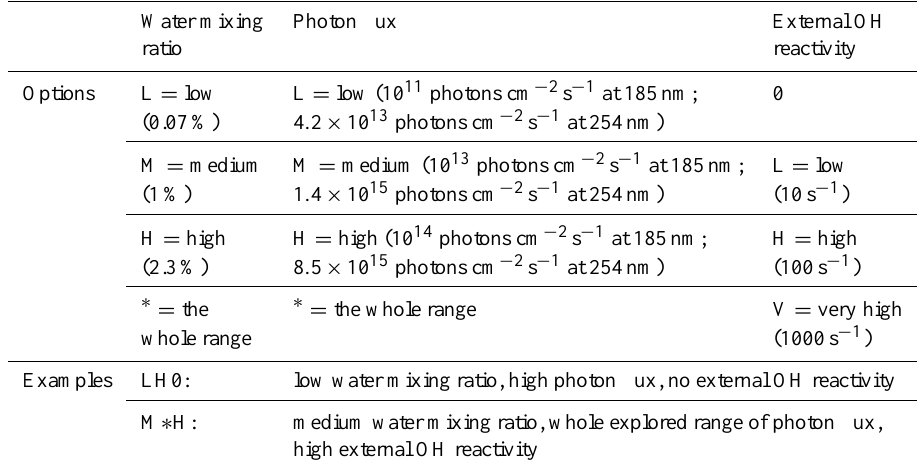
Table 1. Code of the labels of typical cases. A case label is composed of three characters denoting the water mixing ratio, the photon flux, and the external OH reactivity, respectively. Water mixing Photon flux External OH